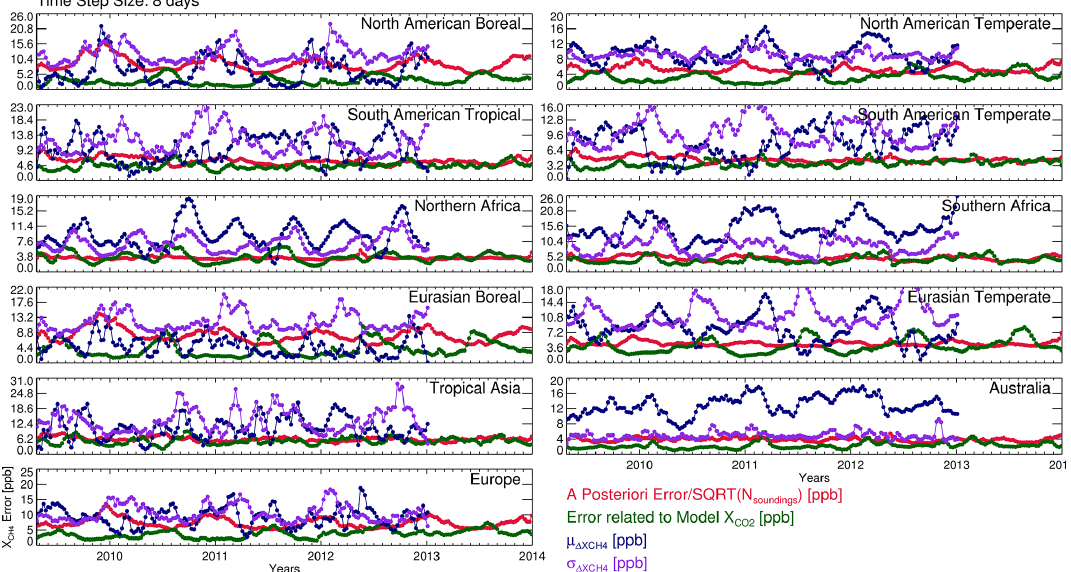
Figure 7. Time series for each Transcom region showing the a posteriori retrieval error (red), the estimated uncertainty from the model XCO 2 (green), and the mean (navy) and standard deviation (purple) of the difference between the GOSAT and MACC-II XCH 4 . The a posteriori error is assumed to be a random error and hence reduces with the square root of the number of measurements whilst the XCO 2 model uncertainty is expected to be a systematic error and hence does not